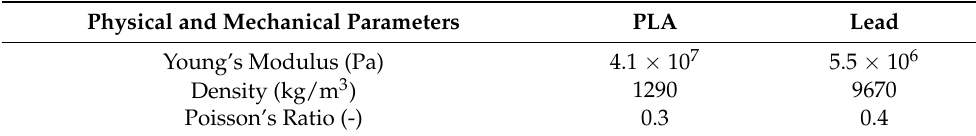
Table 1. Material properties adopted in the